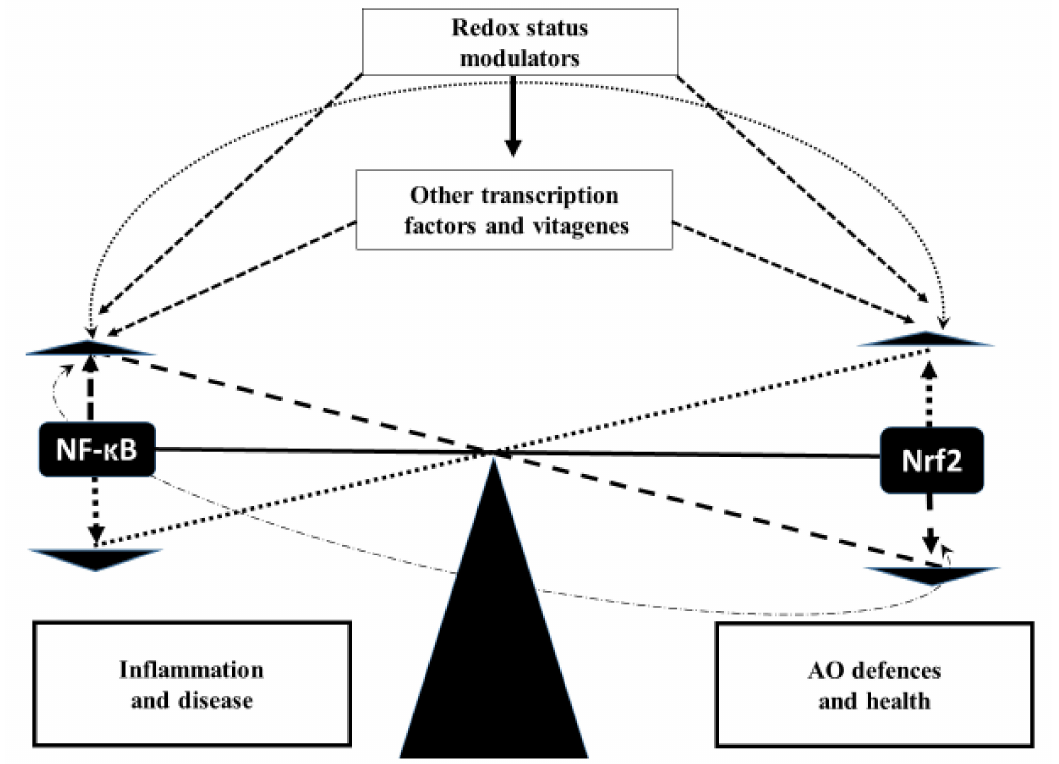
Figure 4. Hypothetical scheme of Nrf2–NF- κ B